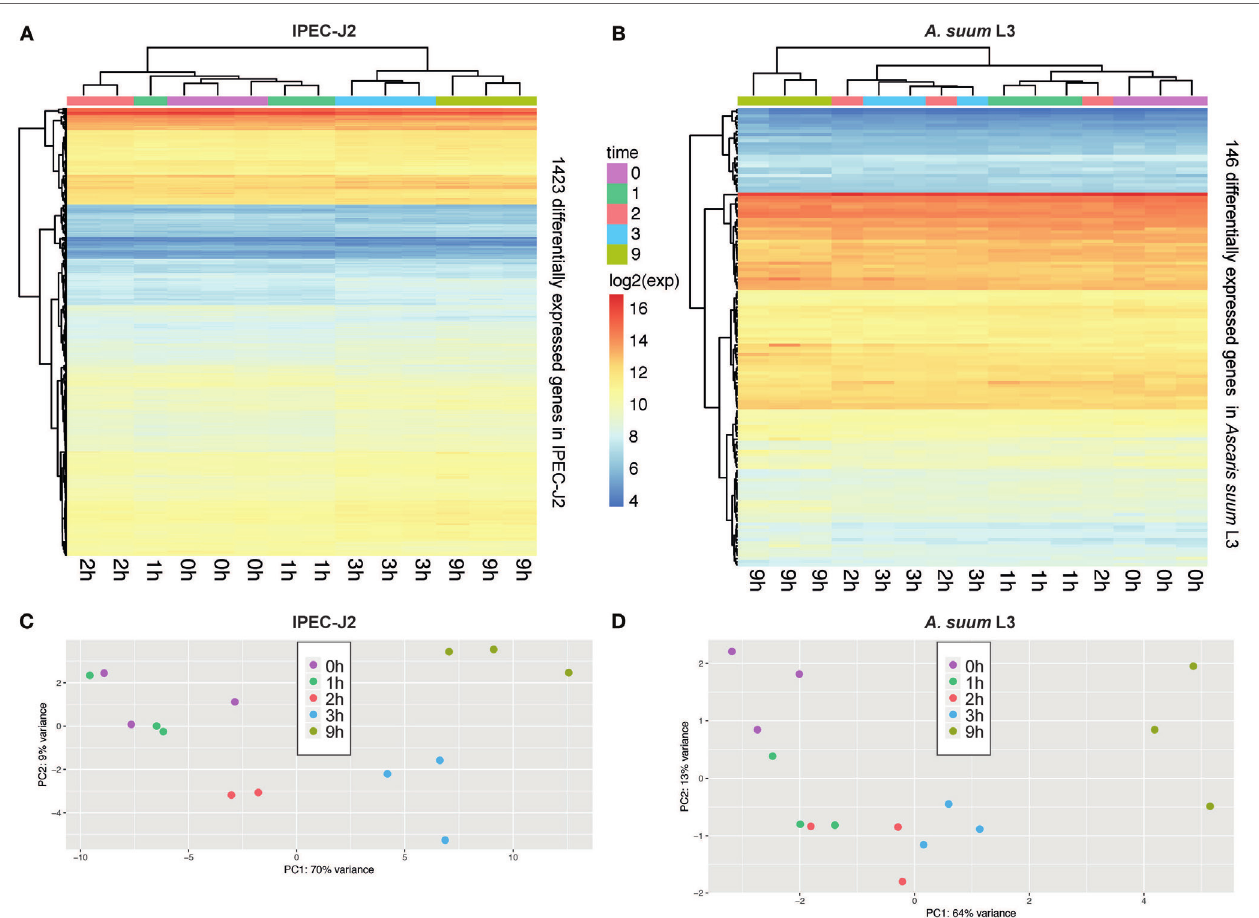
FigUre 2 | Principal component analysis (PCA) of porcine epithelial cells (IPEC-J2) and Ascaris suum L3 expression data and clustering of differentially expressed genes (DEGs). (a) Unsupervised clustering heatmap of DEG in porcine epithelial cells ( n = 1,423, IPEC-J2) and (B) A. suum L3 ( n = 146). Red intensity indicates high gene expression during the time-course of host–parasite co-incubation, whereas blue intensity indicates low gene expression. PCA of RNA-Seq samples of (c) porcine epithelial cells and (D) A. suum L3 reveals that 79% (IPEC-J2) and 77% ( A. suum ) of the data variation is explained by the first two PCs,